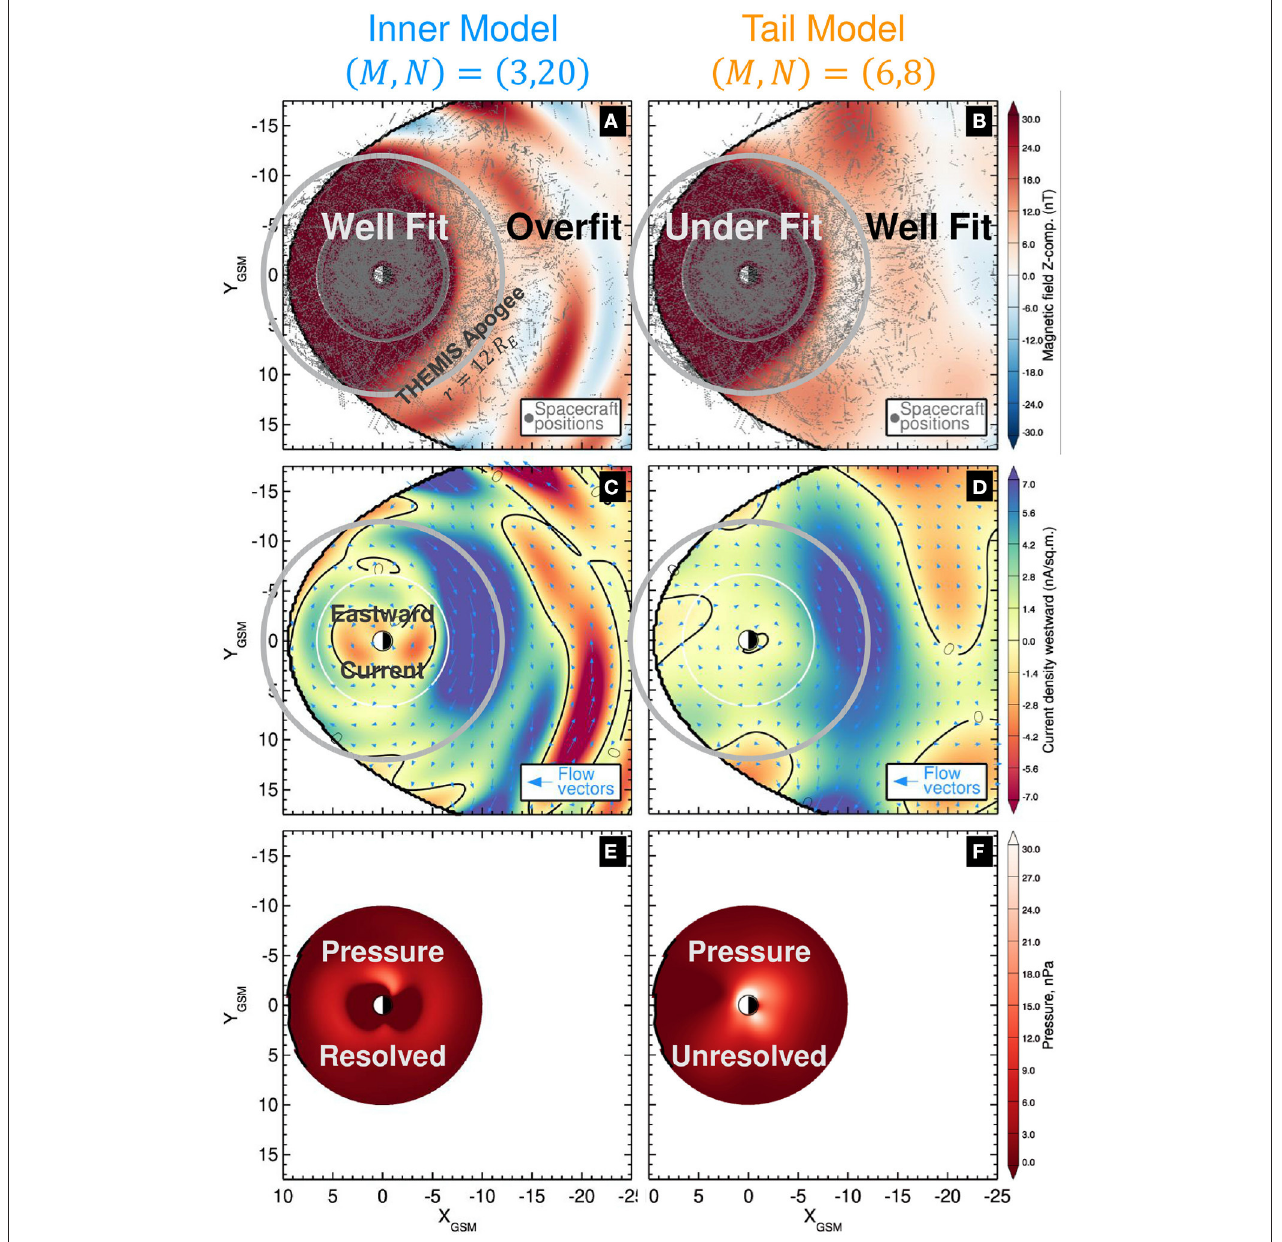
FIGURE 2 | The model resolution dilemma. 2D equatorial distributions of the late growth phase (11:25) of a substorm on 8 March 2009 using two different equatorial resolutions. (A,B) The equatorial distribution of the total modeled magnetic field. The location of the spacecraft magnetic field observations used to fit the model are overplotted with gray dots. The predominant apogee of the inner probes of the THEMIS mission r 12 R E is represented by the gray circle. (B,C) The equatorial = distribution of the current density. The overplotted arrows show the direction and magnitude of the current density vectors. (E,F) The equatorial distribution of the pressure computed by integrating j B according to Equation (11). The Inner Model is used for the left hand panels (A,C,E) which is fit using an equatorial resolution × of ( M , N ) (3,20). It performs well in the inner region but overfits the near-tail region. The Tail Model is used for the right hand panels (B,D,F) which is fit using an = equatorial resolution of ( M , N ) (6,8). It performs well in the near-tail region but under resolves the inner region. =